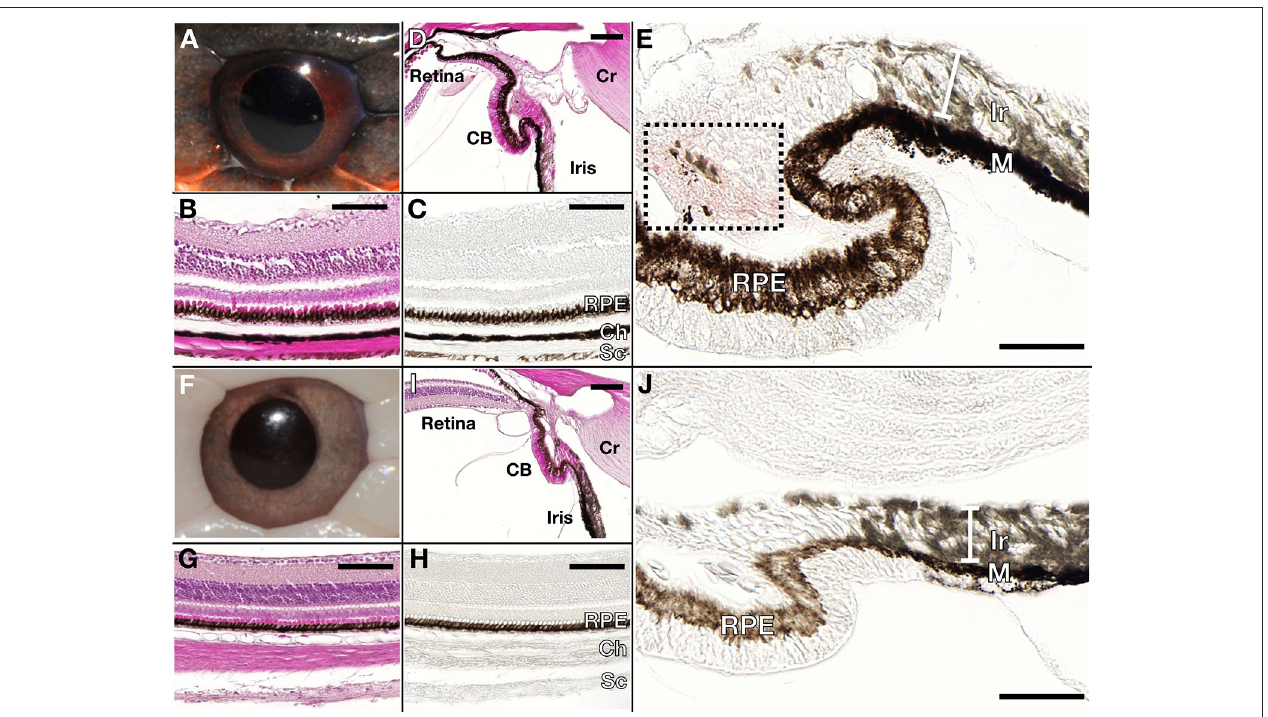
FIGURE 3 | Wild type (A–E) and leucistic (F–J) eye anatomy. Hematoxylin/Eosin stained (B,G) and unstained (C,H) paraffin sections through the retina show that pigmentation is present in the Retinal Pigmented Epithelium (RPE) of both wild type and leucistic snakes, whereas only the wild type choroid (Ch) and sclera (Sc) contain melanophores. (D,I) The RPE of the retina extends in the ciliary body (CB) and in the posterior part of the iris. Red pigmentation (area in black box) is visible in the CB of the wild type (E) but not in the leucistic snake (J) , whereas iridophores (Ir) are found in the anterior part of the iris in both phenotypes (E,J) . M: melanophores, Cr: cornea. Scale bar: 100 µ